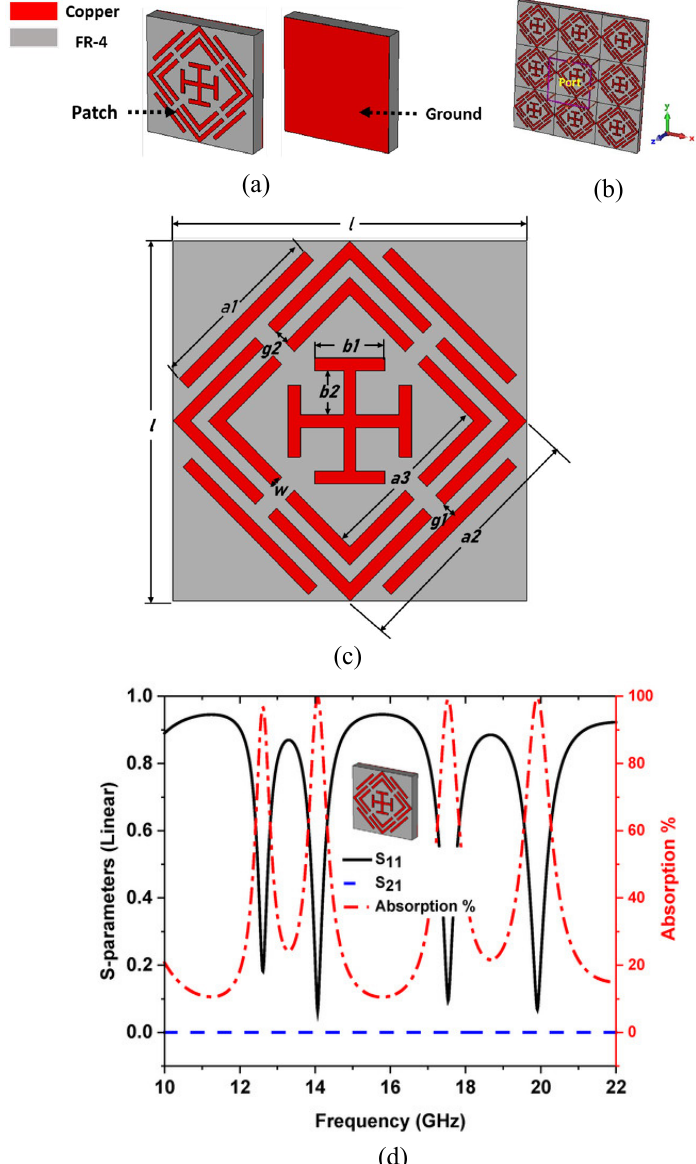
Figure 15. ( a ) Single cell of the absorber ( b ) 3 × 3 array of the absorber ( c ) geometry of reported metamaterial absorber. ( d ) S-parameter plot along with absorption percentage of reported SSRR- loaded metamaterial absorber. Reprinted from Ref. [167].